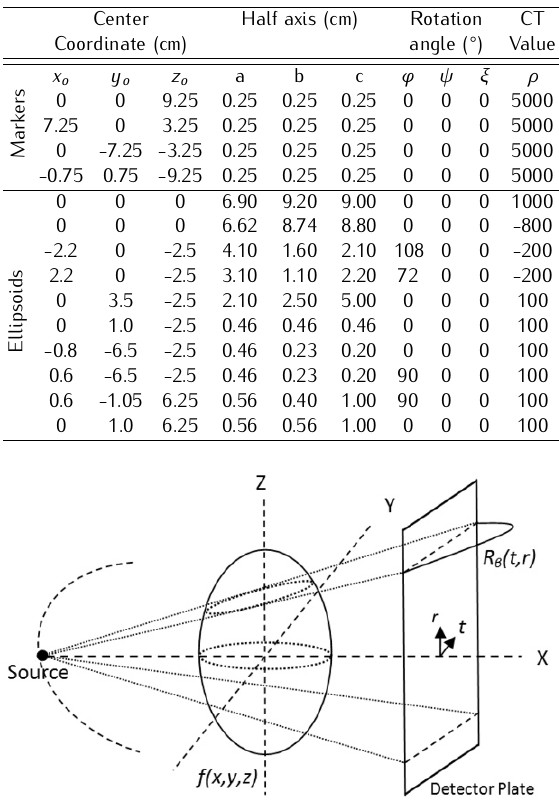
Figure 2. Circular Cone-beam CT